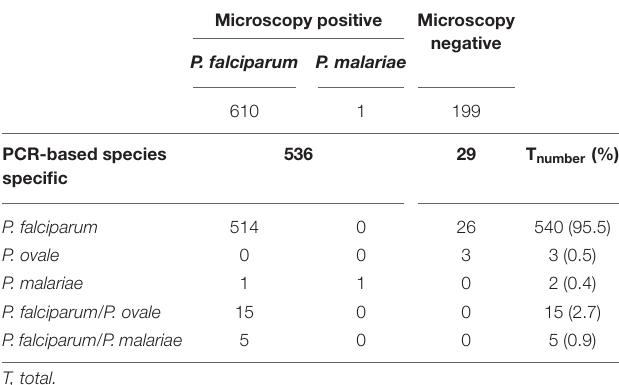
TABLE 3 | Plasmodium species identified in 565 malaria patients from high transmission areas in southern Togo, 2017–2019. Microscopy positive